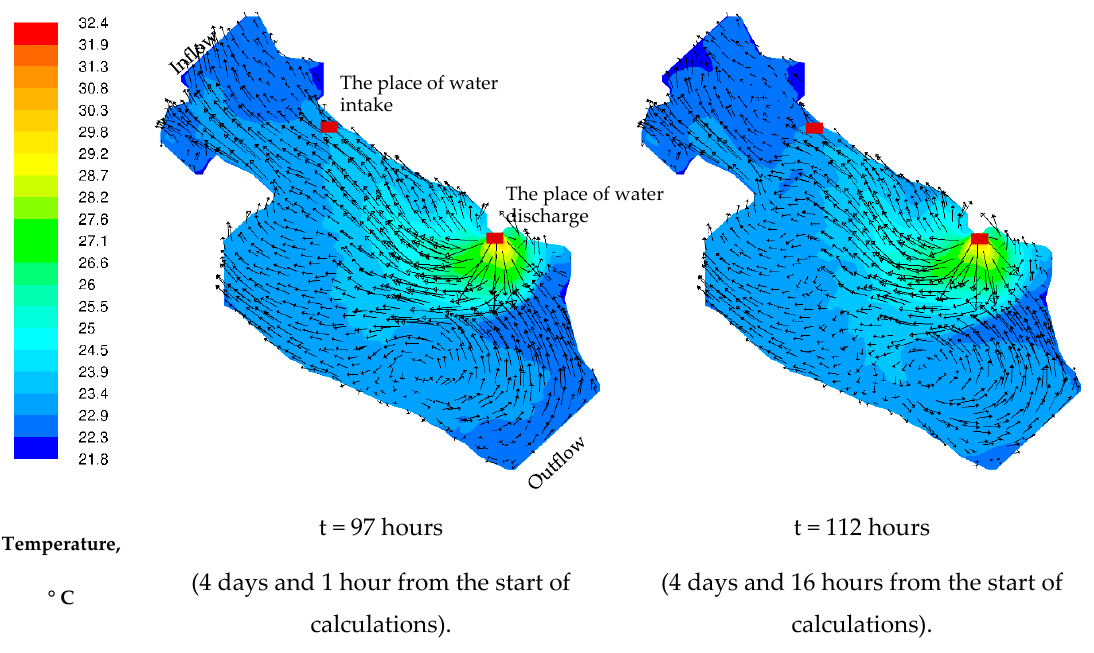
Figure 8. Temperature fields in the near-surface layer for southeasterly wind; the time from the start of calculations (t). The calculations were carried out for the period starting from midnight.